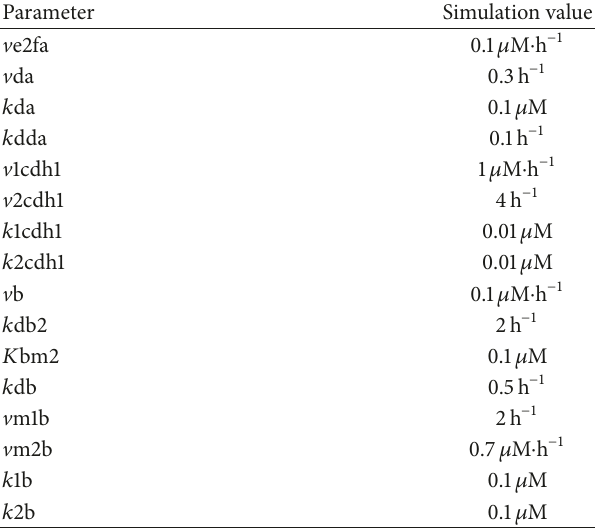
Table 2: Simplified parameter table.